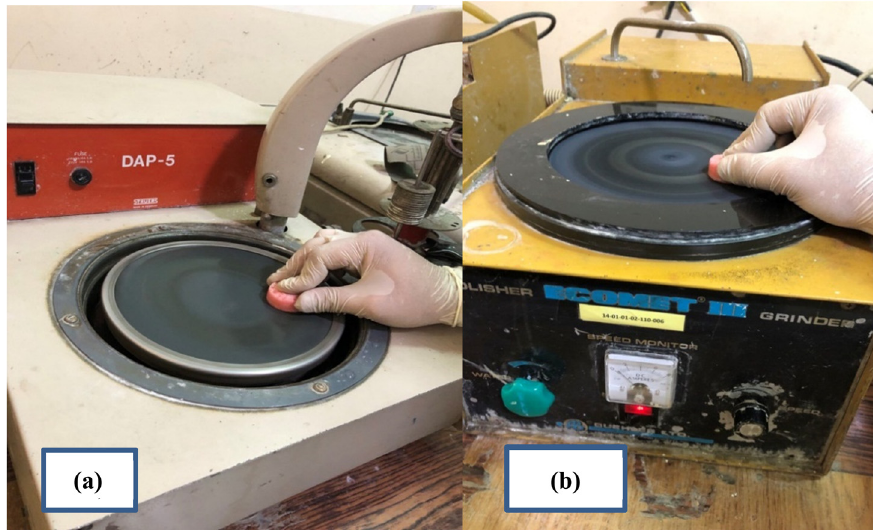
Figure 3: ( a ) Grinding process. ( b ) Polishing Process.